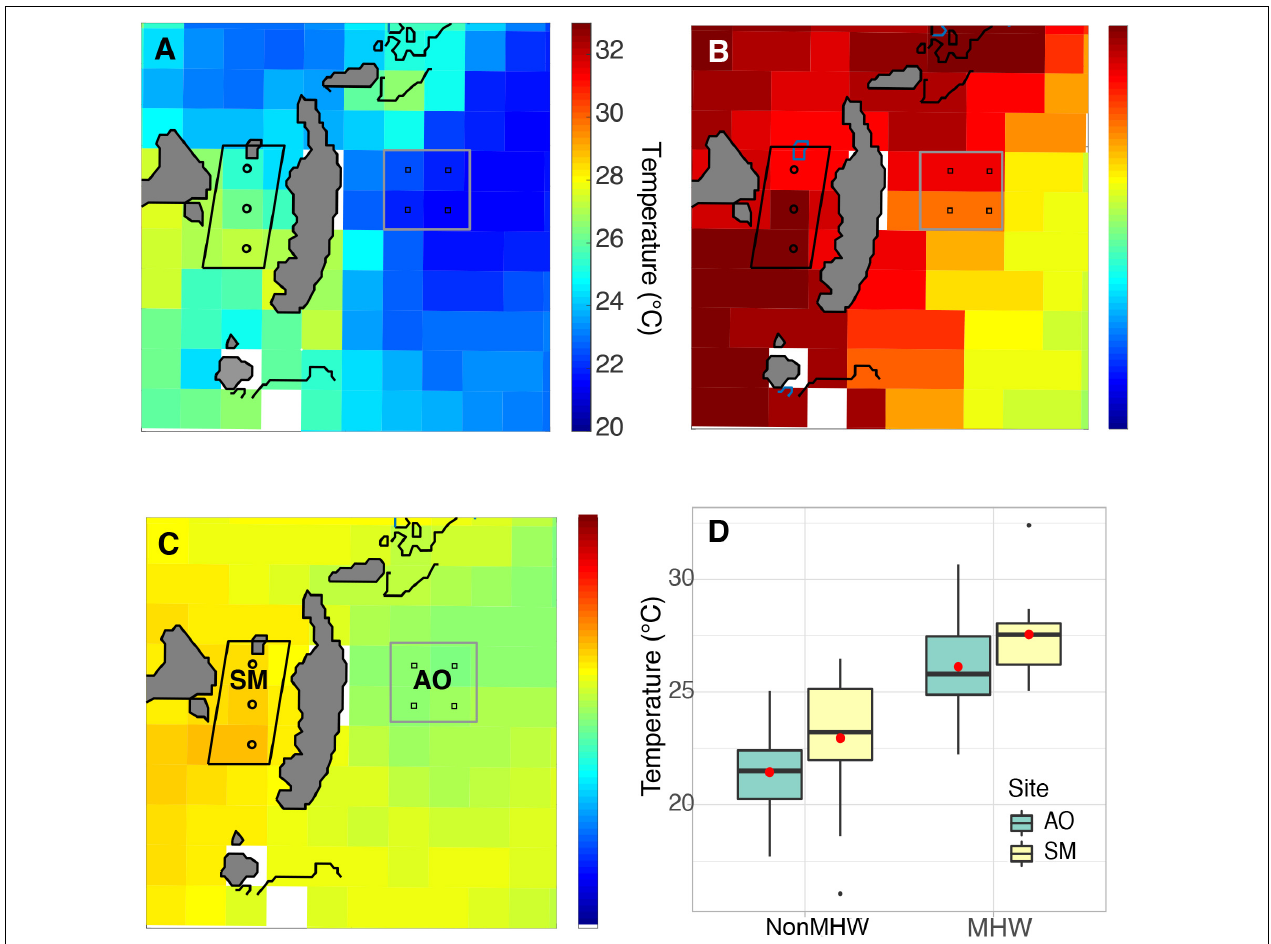
FIGURE 3 | Sea surface temperatures from before (A) , during (B) , and after (C) the June 2015 MHW show cooler waters in the Atlantic Ocean (AO) compared to warmer waters in the seagrass meadow (SM). Image pixels for each area are identified in panel (C) ; images are from 11 June (A) , 16 June (B) , and 29 July (C) . Temperature differences between the ocean and meadow regions for all available satellite images from June 2015 are shown in panel (D) ; seagrass meadow waters were on average 1.1–1.5 ◦ C warmer than the Atlantic Ocean waters under MHW and non-MHW